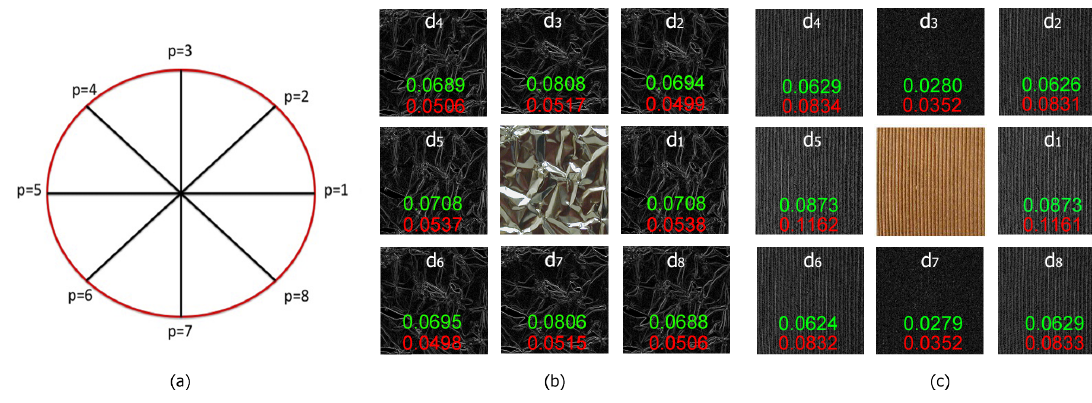
Figure 4. ( a ) Circumference that represents the neighborhood considered for the computation of CLOSIB with P = 8. Four pairs of neighbors differ in π radians, such as the neighbors for values p = 2 and p = 6. ( b , c ) Schemas that represent the computation of CLOSIB 8,1, θ for two different images. We show the original image in the centre and the eight images of the absolute differences of the gray values d p ( x c , y c ) in the outer layer. The red and green numbers indicate the values of each element of CLOSIB 8,1,1 and CLOSIB 8,1,2 feature set, respectively, obtained for the corresponding p values of d p ( x c , y c ) . Note that the values of the elements of CLOSIB computed for neighbors that differ in π radians diverge in only a maximum of 0.0002 units whereas the ones that differ in a different angle diverge in at least 0.0006 units.